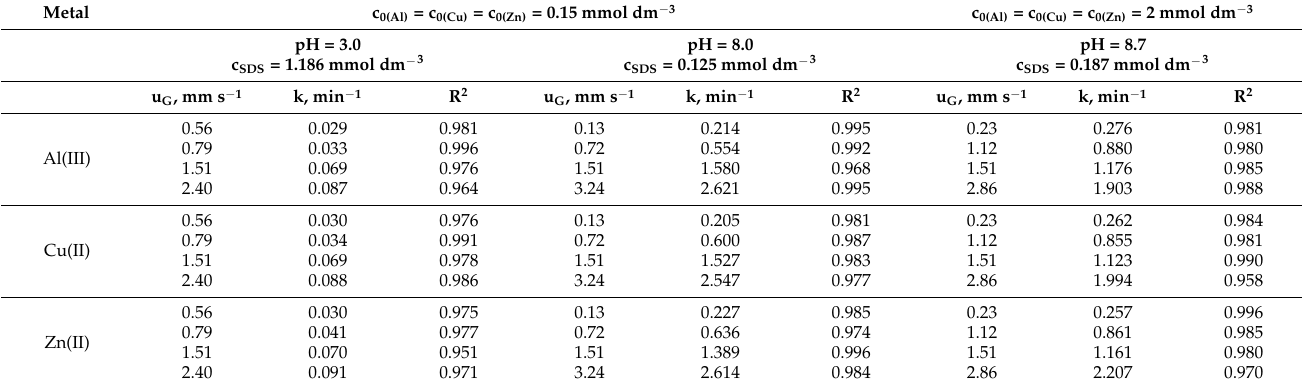
Table 7. Effect of the air velocity on the values of the ion and precipitate flotation rate constants for Al(III), Cu(II), and Zn(II). Metal